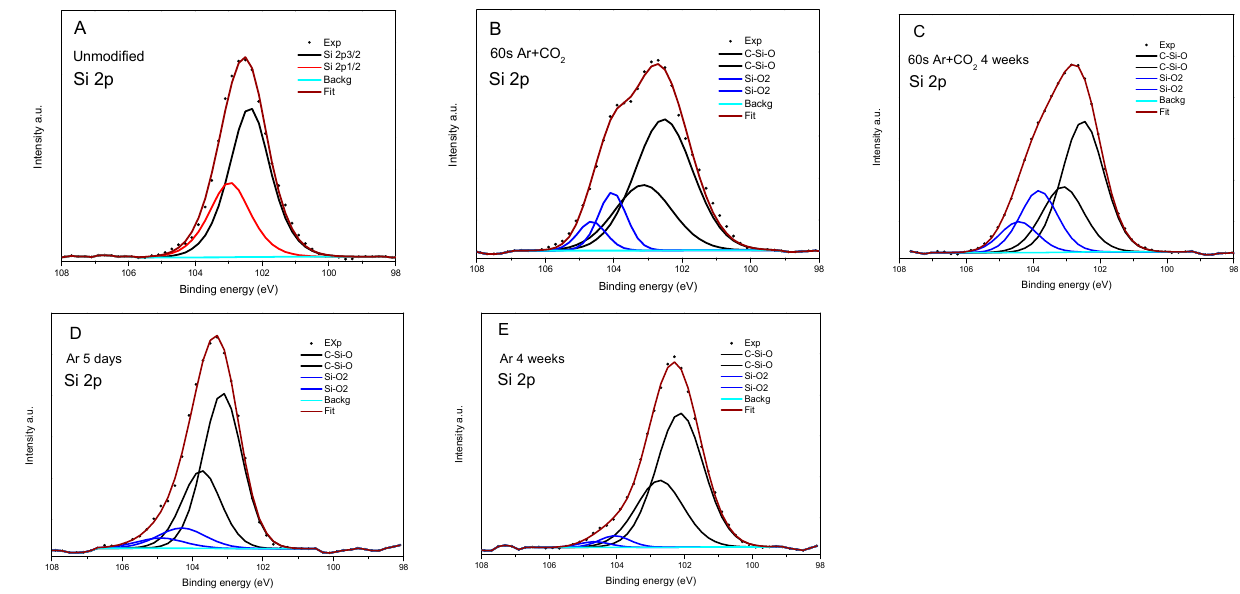
chemical formula of silicone, where n is the number of repeating monomer.